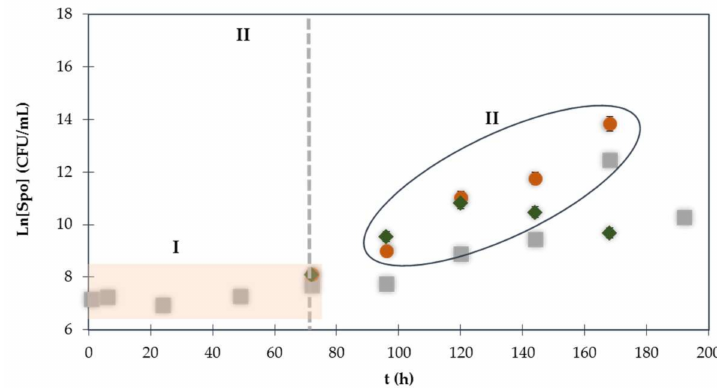
Figure 2. Time course profile of Bacillus spore formation, before and after the peptone supplementation and heat activation assays. ( ) Normal growth in NB culture medium; ( ) NBPSHA assay; ( ) NBPS assay. I —Spore concentration baseline, II —Time with high spore concentration alteration.